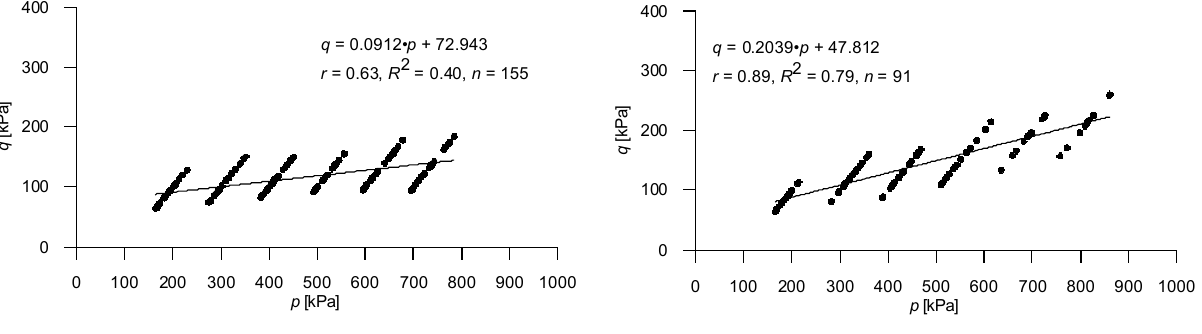
Figure 18: Result of strength tests for soil B-3.